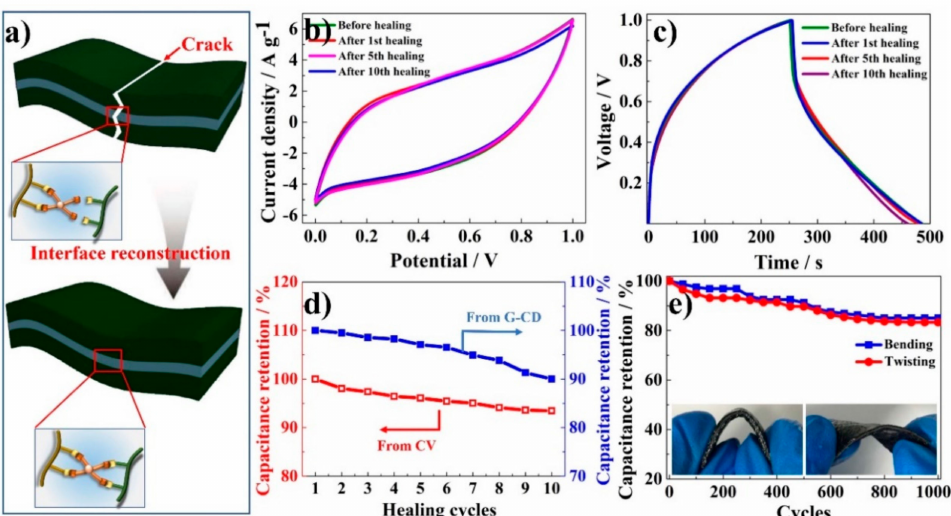
Figure 8. ( a ) Schematic and structural illustration of the self-healing process due to the dynamic borate bond of the supercapacitor. ( b ) CV curves at initial and after the 1st, 5th, and 10th self-healing at a scan rate of 40 mV s − 1 . ( c ) G-CD curves at initial and after the 1st, 5th, and 10th self-healing at a current density of 0.6 A g − 1 . ( d ) Self-healing e ffi ciency derived from both G-CD and CV curves at self-healing cycles from 1st to 10th. ( e ) Capacitance retention over 1000 bending and twisting cycles at an angle of 180 ◦